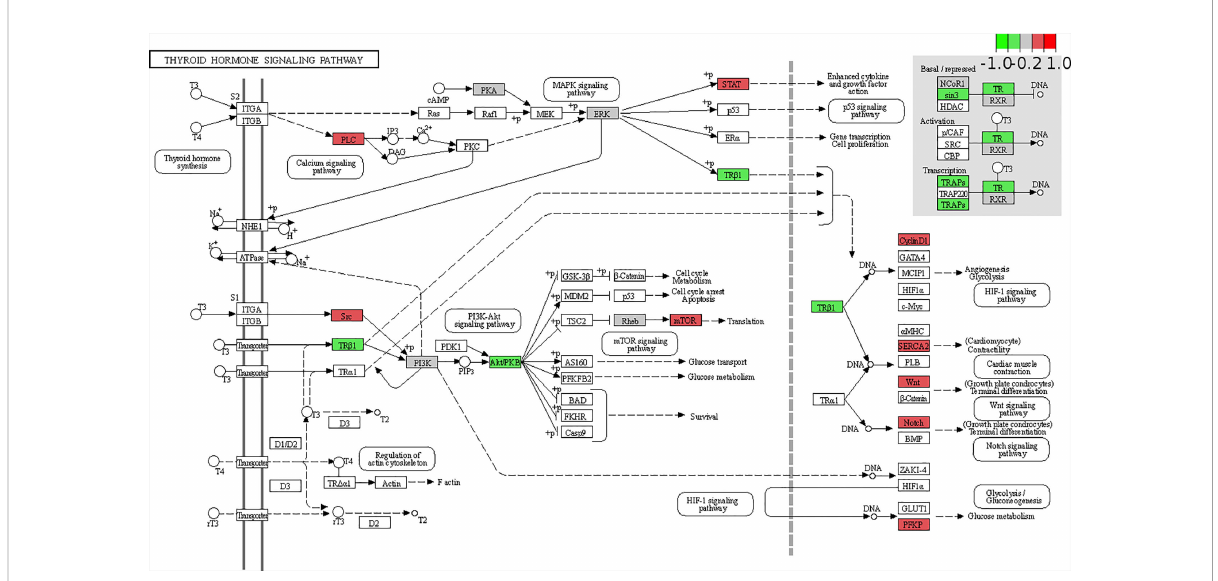
FIGURE 3 Expression changes of target genes of thyroid hormone signaling pathway in patients with non-alcoholic fatty liver disease (NAFLD) are mapped by colors. The color depth positively correlated with the degree value. Red represents increased while green represents decreased gene expression in NAFLD group compared with that in the health obese